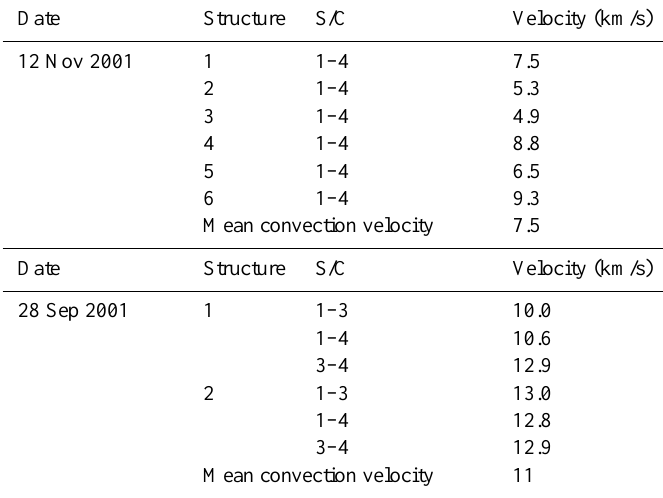
Table 1. The structure’s velocity computed from the Cluster